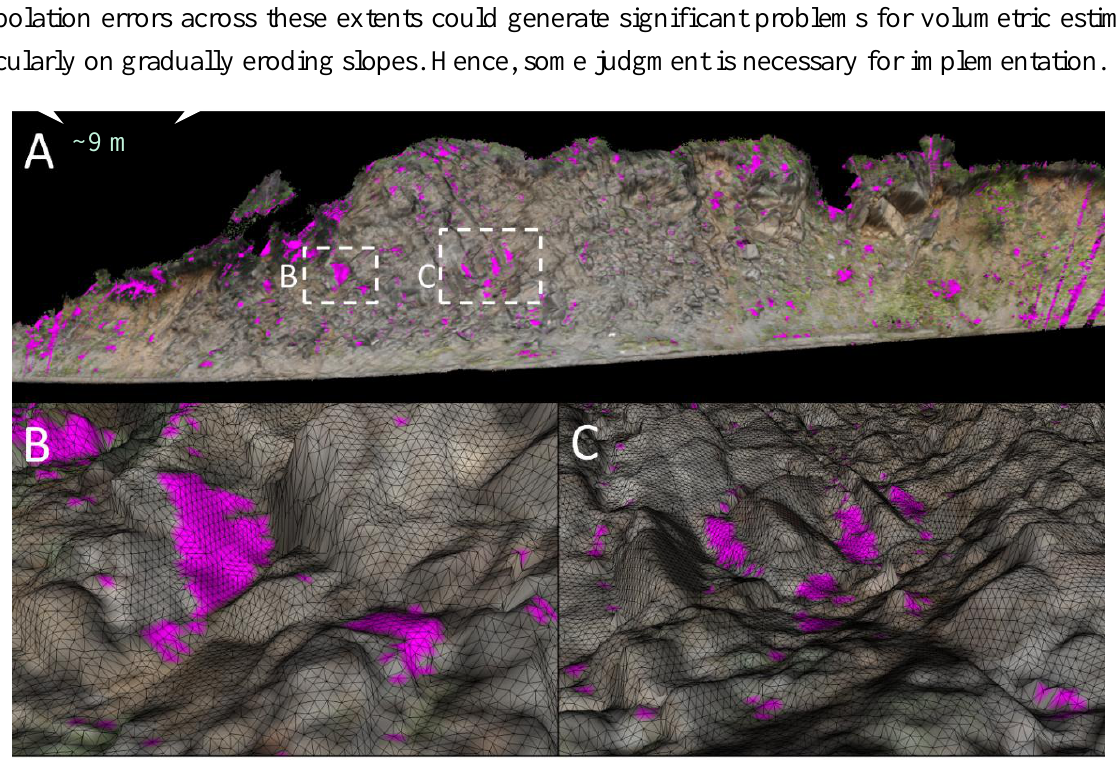
Figure 6. Example of hole filling for the 2014 surface model for Site A using a grid cell size of 0.05 m and window size of 20 ( i.e. , TPS search window of 41 × 41 cells (2 × 2 m) but hole fill size of 21 × 21 cells (1 × 1 m)) . Inserts B and C show more detail of the TPS effectively filling both large and small holes . The filled holes are shown in magenta while scan data are shown with the natural RGB